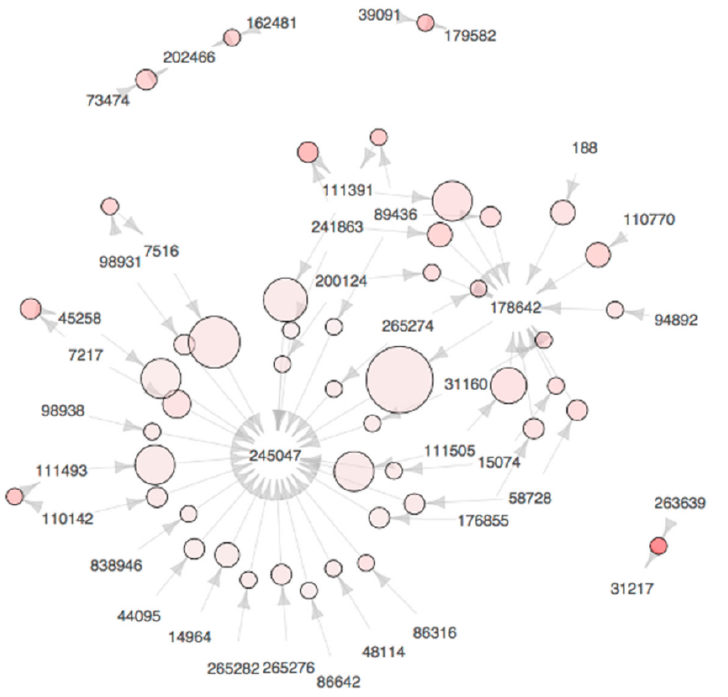
Figure 3. Association rule visualization for Scenario 1 Class 1-2. Note that the numbers indicate SKUs, size of circle indicates level of support (0.20–0.54) and color indicates level of lift